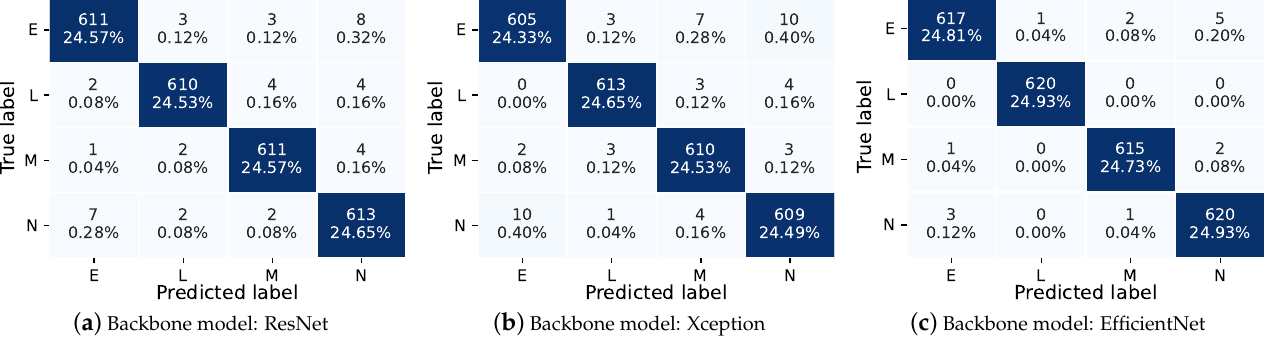
Figure 8. Confusion matrix of the presented WBC classification model using different backbone configurations. Note that E: Eosinophils, L: Lymphocytes, M: Monocytes, and N: Neutrophils.